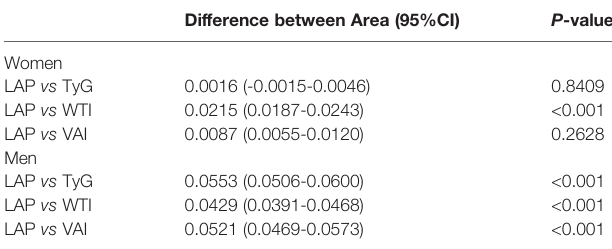
TABLE 3 | Comparison of AUC values between LAP and other indexes in both